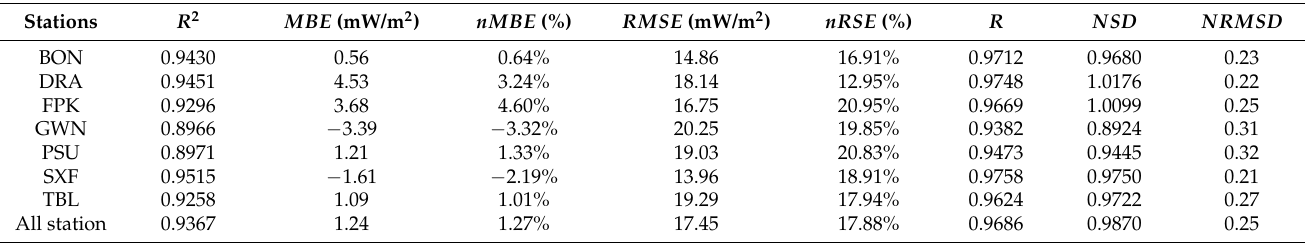
Table 6. Performance evaluation of the DRFCN+RF model on the SURFRAD-2017 dataset (including the results of the SURFRAD seven stations and their aggregated